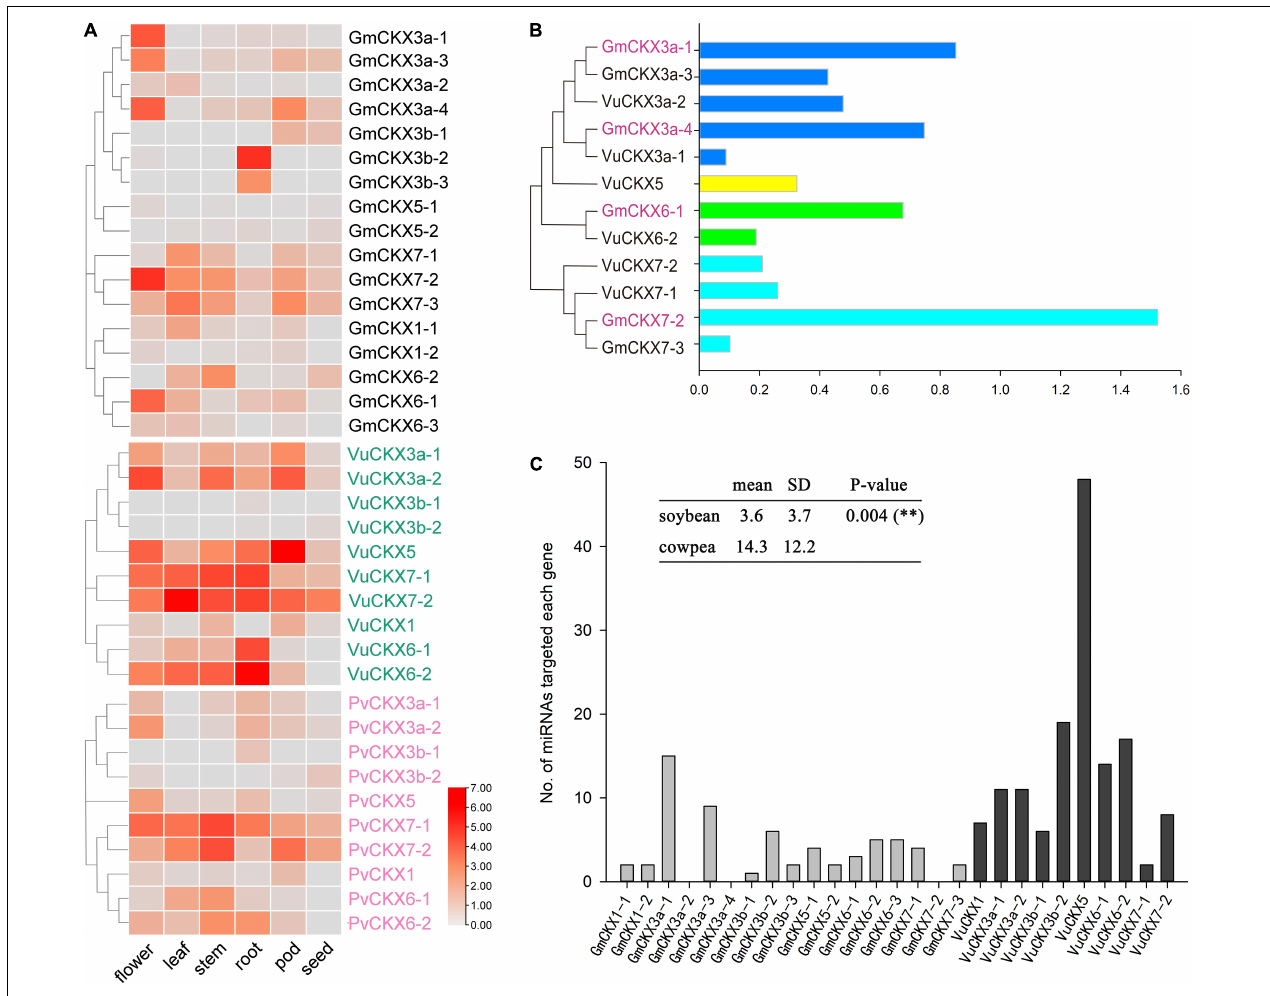
FIGURE 4 | Expression patterns and regulation of CKX gene family. (A) Expression levels of CKX gene family in flower, leaf, stem, root, pod, and seed of soybean, cowpea and kidney bean. (B) Relative expression levels of CKX gene family in soybean and cowpea flowers. (C) The numbers of miRNAs targeted each CKX